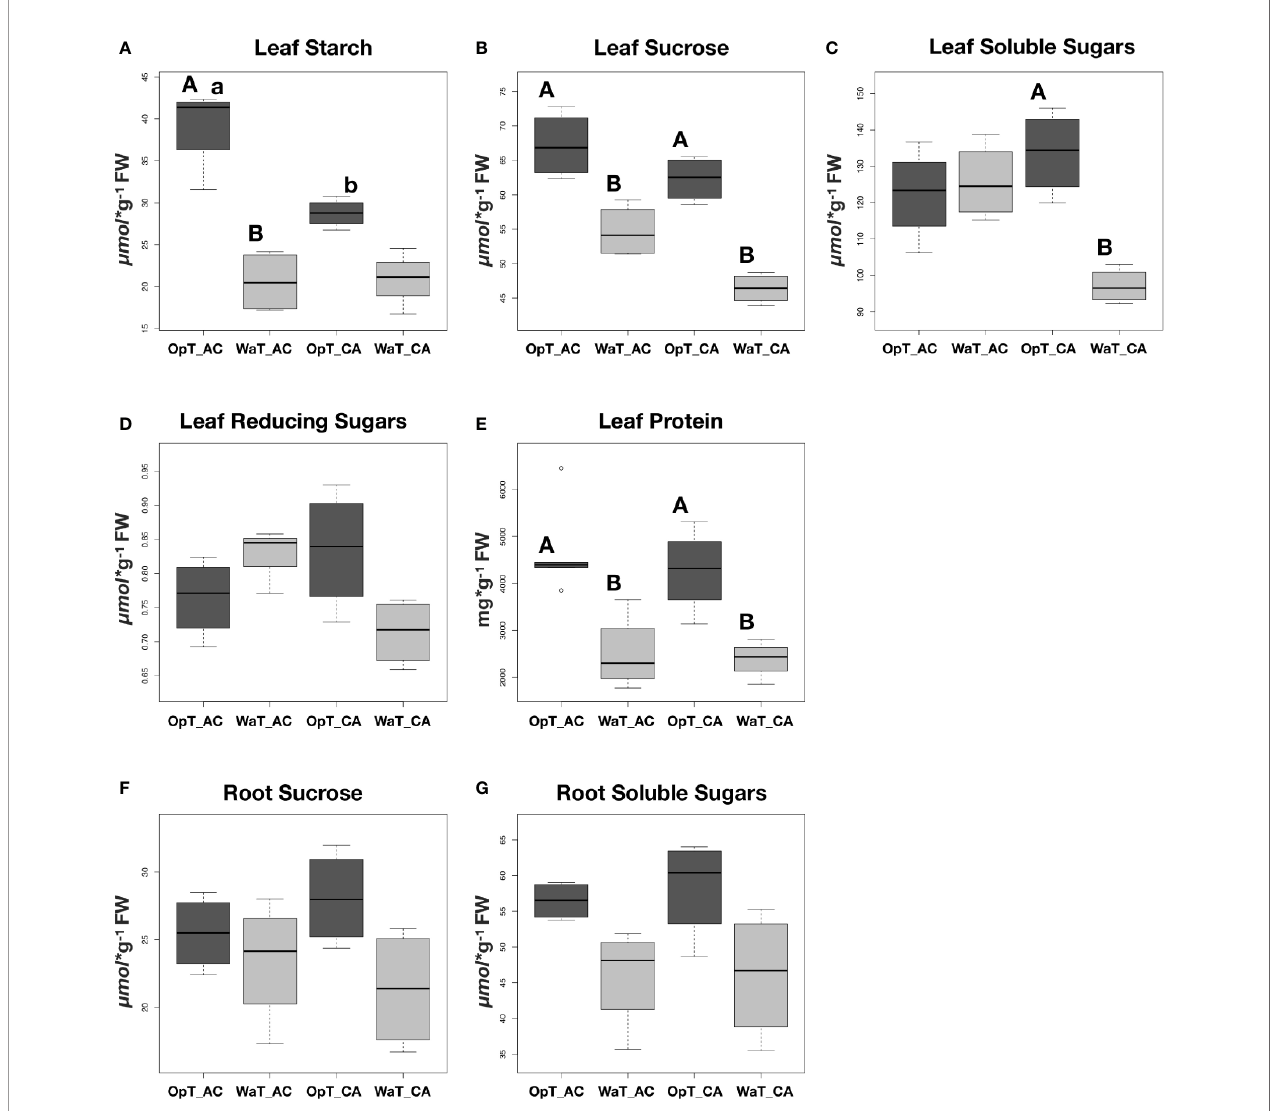
FIGURE 4 | Boxplot analyses of different sugars and protein content in leaves and roots of two coffee genotypes under two temperature conditions. Coffee genotypes, cv. Acauã (AC) and Catua ı ́ (CA) were subjected to two temperature conditions (OpT and WaT) and the starch content (A) , sucrose (B) , soluble sugars (C) , reducing sugars (D) , and protein (E) were determined in leaves. The content of sucrose (F) and soluble sugars (G) were also measured in roots. Statistical analyses were performed comparing the same coffee genotype at different temperatures (capital letters) and comparing different genotypes at the same temperature (small letters). Differences were considered signi fi cant at p<0.05 (see Table S4 for details). Labels: OpT, optimal temperature (23/19°C, day/night); WaT, warm temperature (30/26°C, day/night); CA, cv. Catua ı ́ ; AC, cv. Acauã. Each box represents the distribution of values for eight plants in a given